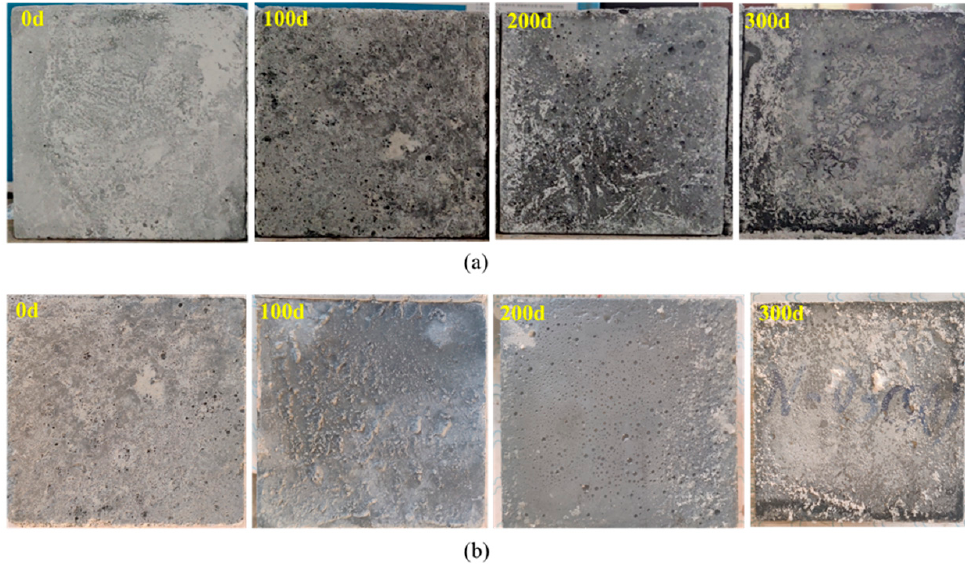
Figure 5. Concrete surface subject to sulfate attack: ( a ) 0% Nano-silica HPC; ( b ) 1% Nano-silica HPC.